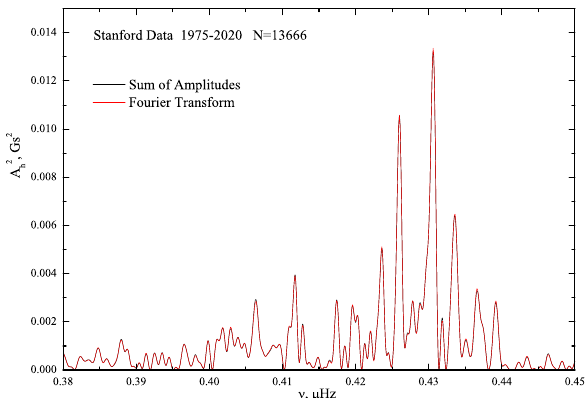
Figure 7. The power spectra of the time series, calculated in two ways: 1) the Fourier transform according to the formula (3) (red line) and 2) the sum of the amplitudes of the sinusoids according to the formula (5) (black line).